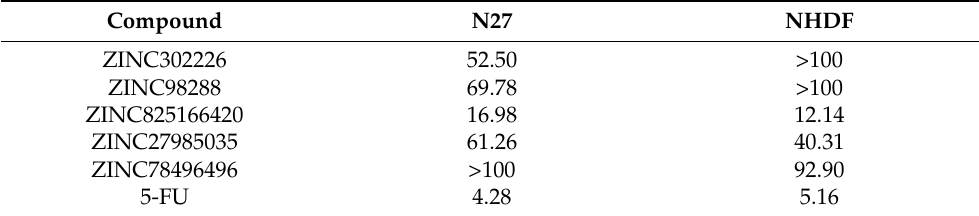
Table 4. Estimated IC 50 values ( µ M) for selected compounds in dopaminergic neuronal (N27) and normal fibroblast (NHDF) cells a